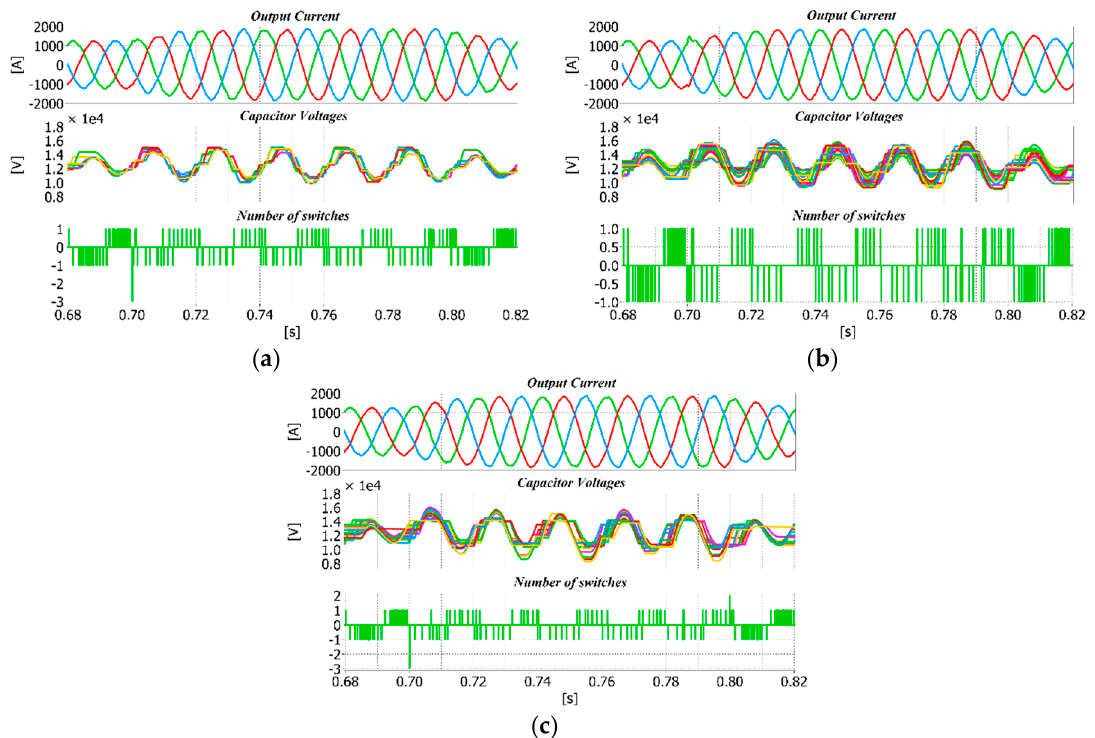
Figure 7. Output currents, capacitor voltages and number of switches per each T s in simulation during phase to ground fault: ( a ) Bubble Sorting Algorithm; ( b ) max/min approach and ( c ) proposed mapping strategy M = 8 with the switching frequency optimization.